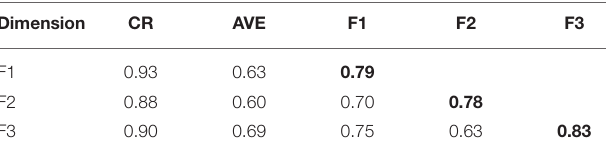
TABLE 7 | CR, AVE, and correlation coefficients between factors in Affection subscale.